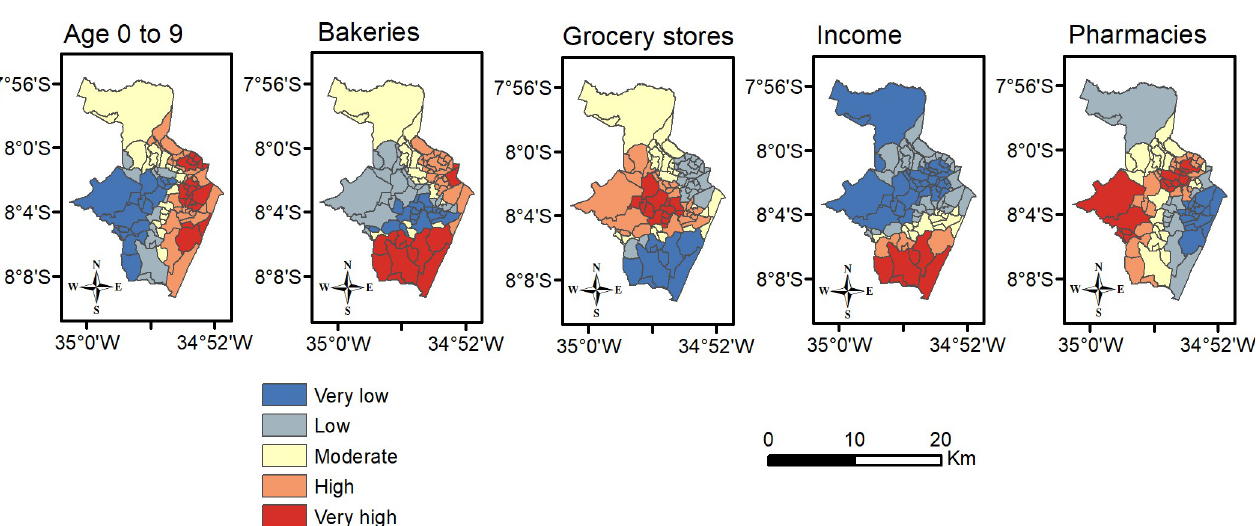
Fig 7. Effects of determinants on prediction of COVID-19 cases according to their coefficients in GWR regression. Sources: Brazilian Institute of Geography and Statistics (IBGE) 2021, and software ArcGIS 10.4.1.